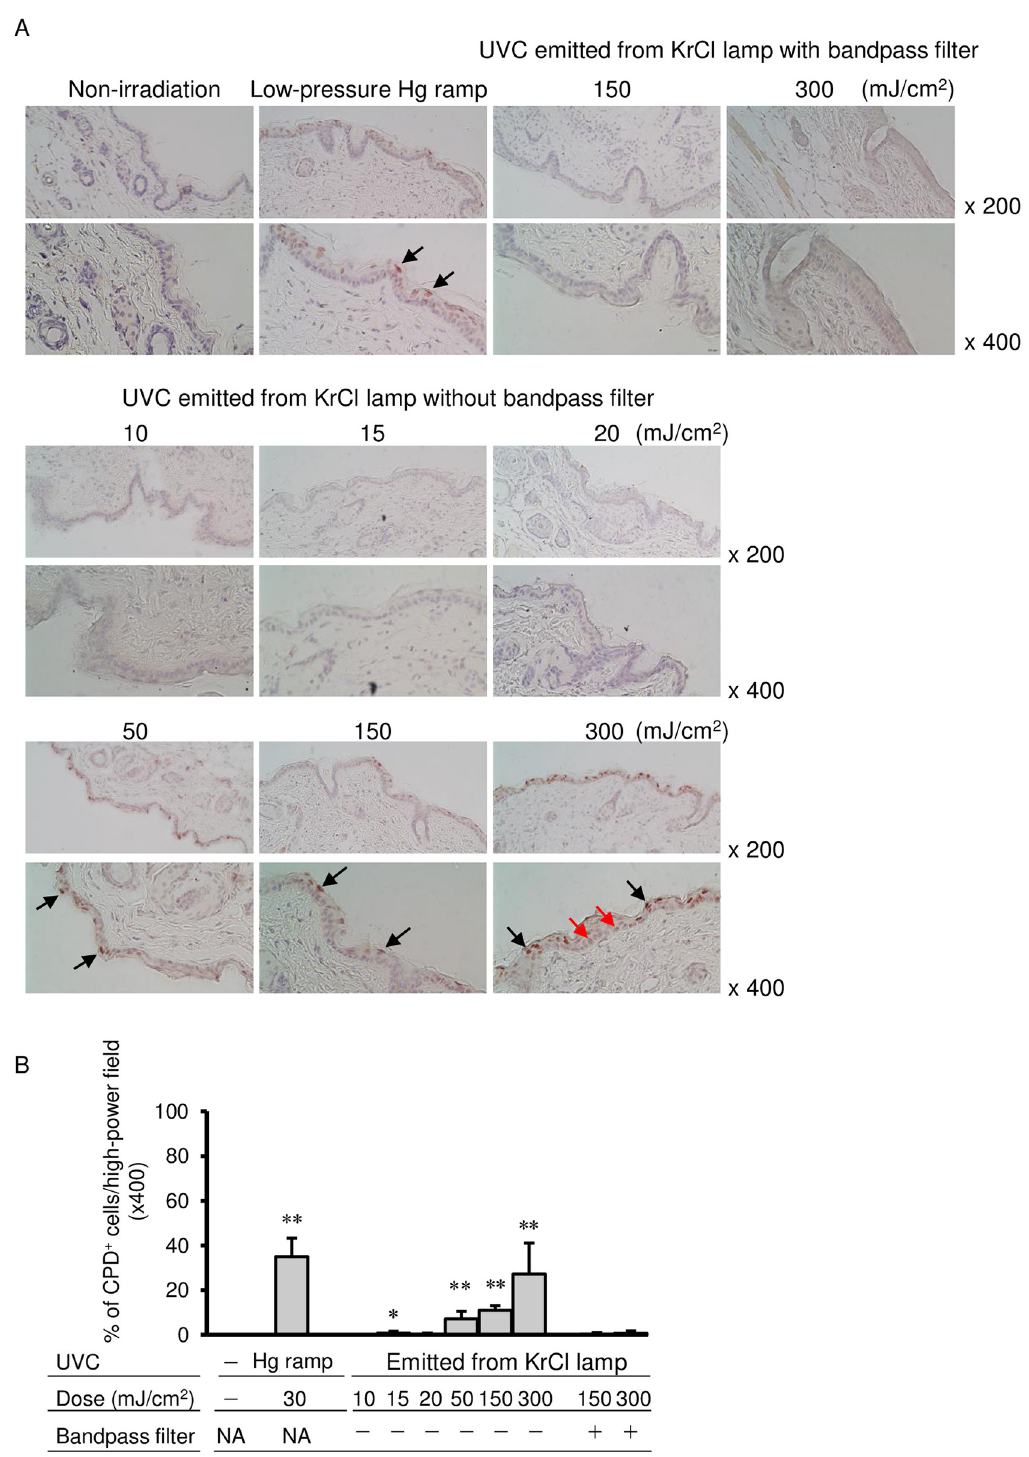
Fig 2. Histological analysis of dorsal skin of mice irradiated with UVC emitted from a KrCl lamp with or without a bandpass filter. The dorsal skin of mice was irradiated with UV radiation from a low-pressure Hg lamp, UVC emitted from a KrCl lamp with a bandpass filter at 150 and 300 mJ/cm 2 or UVC emitted from a KrCl lamp without a bandpass filter at 10, 15, 20, 50, 150 and 300 mJ/cm 2 . The skin specimens were stained with anti-CPD antibody as described in the Materials and Methods section. Black arrows indicate CPD-positive cells, and red arrows indicate CPD-positive cells in the basal layer of the